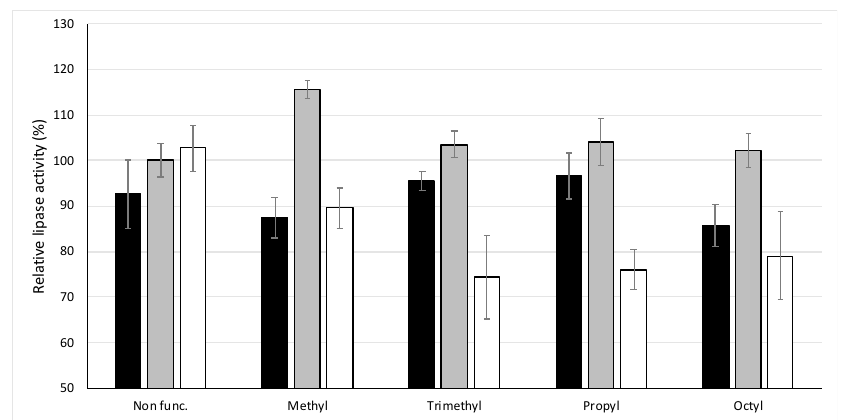
Figure 2. Lipase activity in the presence of bile salt (NaTC). Black column U-Cx; Grey column MS-Cx and white column SP-Cx.